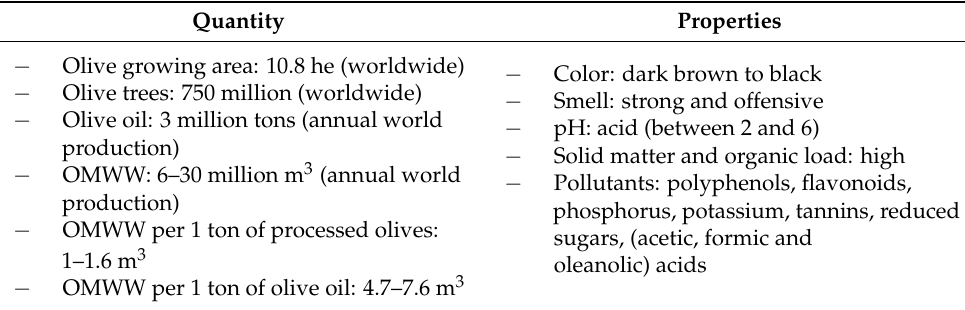
Table 1. Quantity and properties of OMWW (based on